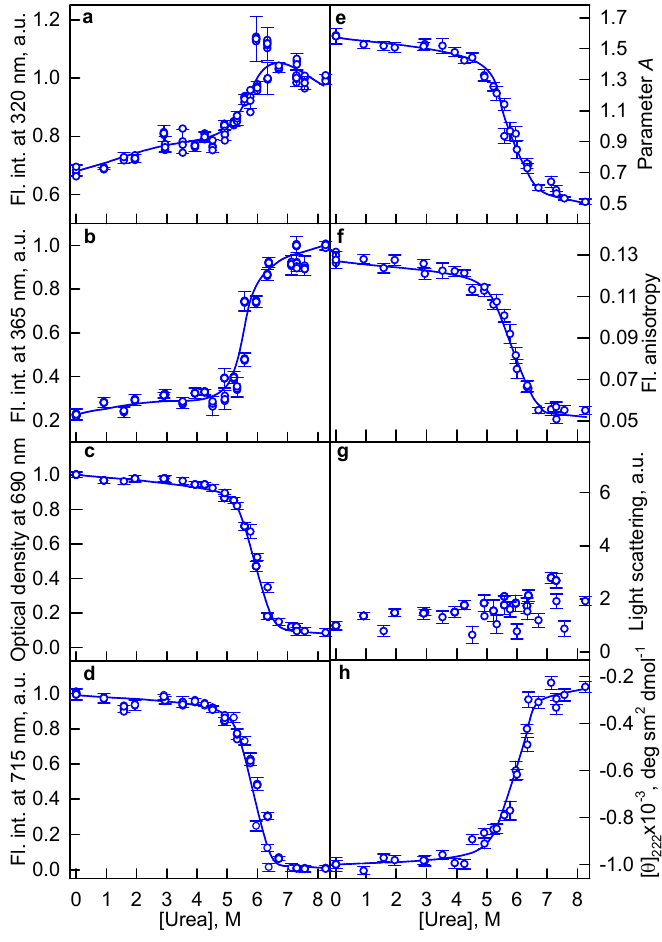
Figure 3. Unfolding of iRFP713 in the holoform induced by urea. See Figure 2 for the details. The GdnHCl-induced unfolding of iRFP713 in the holoform started at higher denaturant concentrations and was more cooperative than the apoprotein unfolding. This indicates that BV resided in the GAF pocket of the holoprotein and stabilized it up to the GdnHCl concentrations at which protein structure